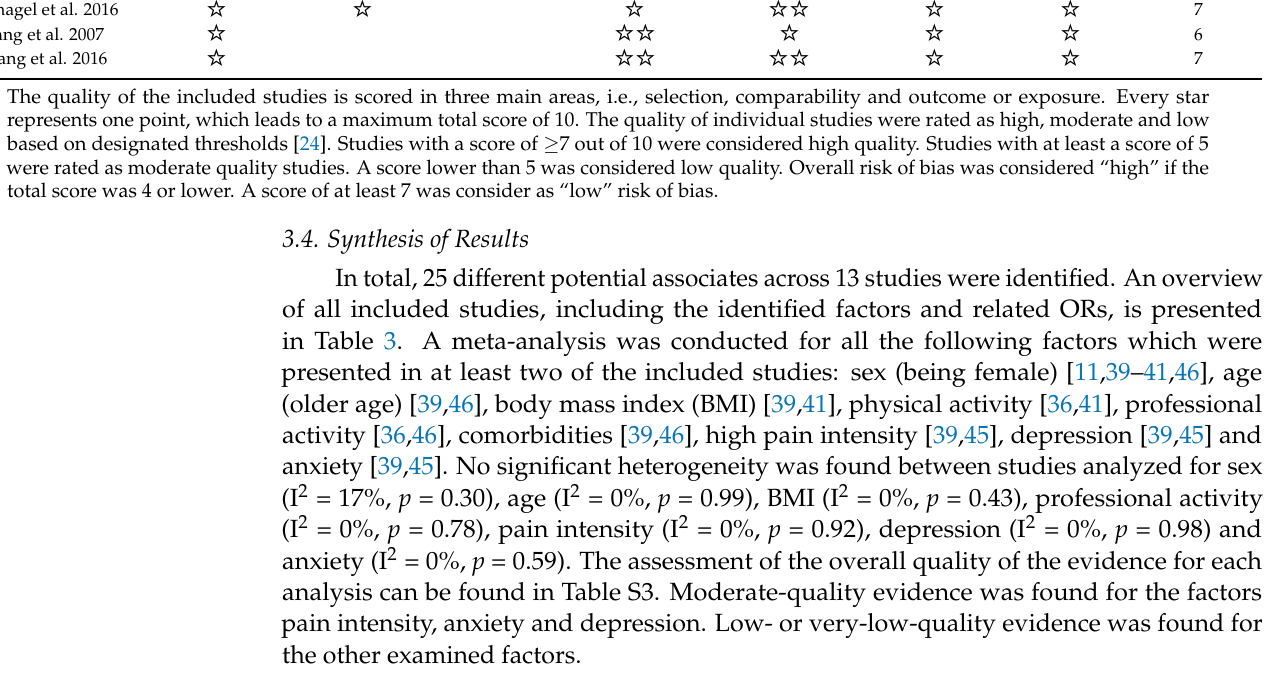
Table 2. Quality assessment by the Adapted Newcastle–Ottawa scale.